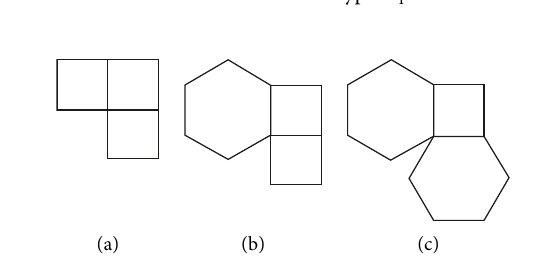
Figure 1: Kinks of type T